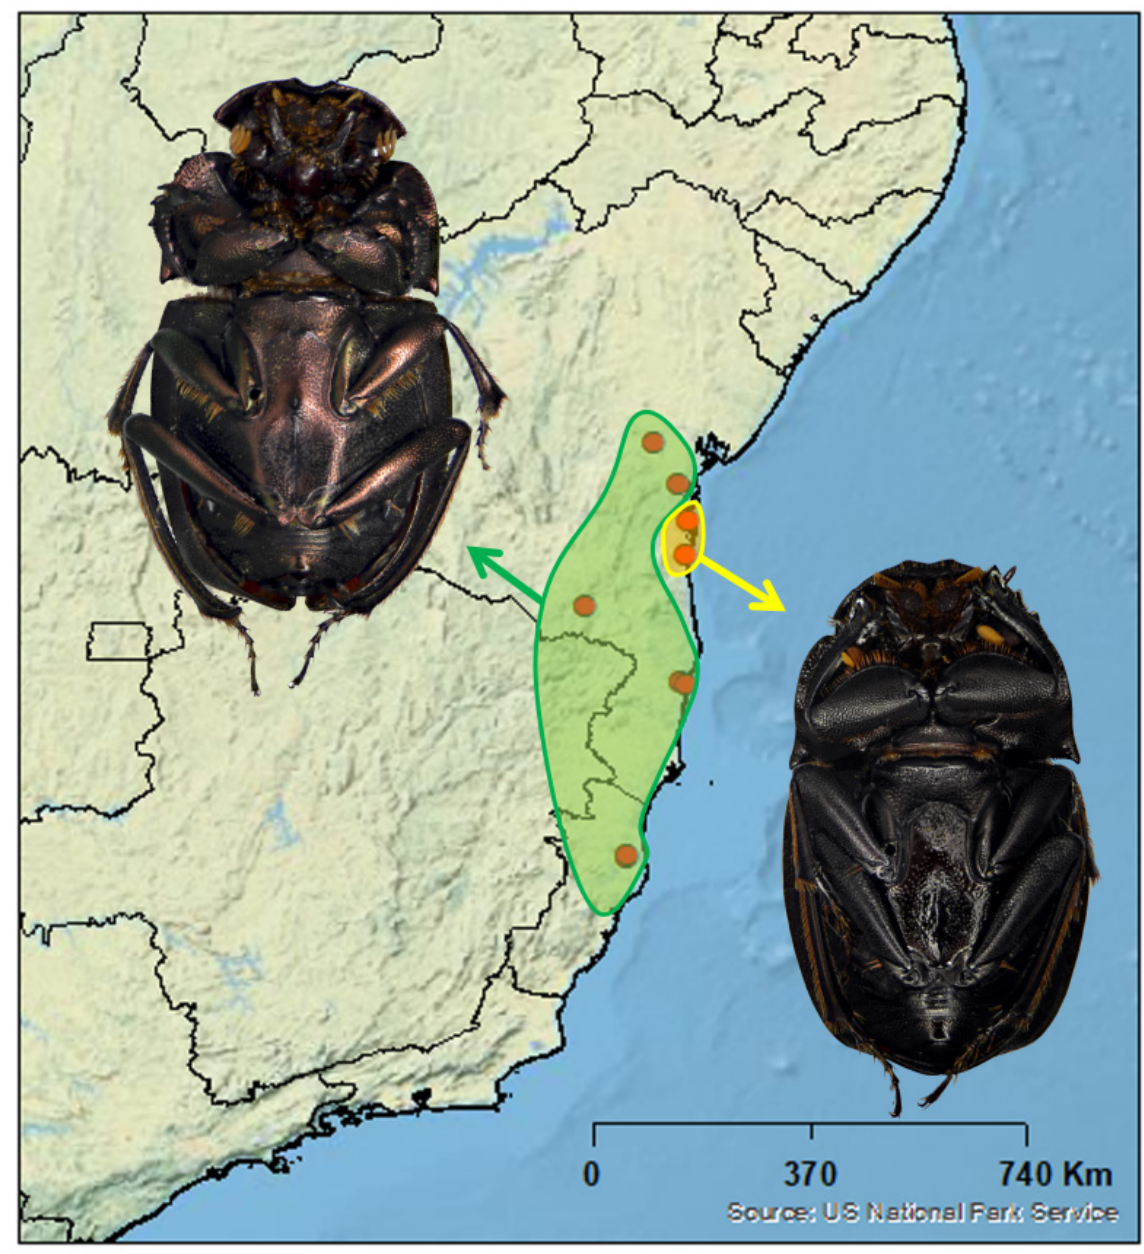
Fig. 2. Geographical variation in Streblopus opatroides van Lansberge, 1874. Individuals from a few localities in southeast Bahia (Maraú and Uruçuca) have a different ventral colouration from individuals belonging to other populations, being much darker and not showing the typical red metallic colouration seen in specimens from other localities in Bahia and Espírito